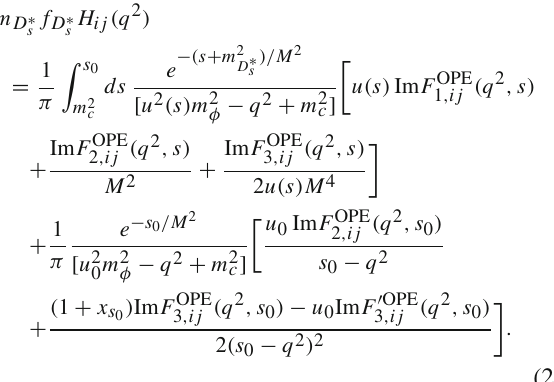
Table1 TheanatomyoftheLCSRsuncertaintyofhelicityformfactors ( q 2 ) , the center value (CV) is obtained by setting M 2 = 4 . 5GeV 2 H ij and s 0 = 6 . 8GeV 2